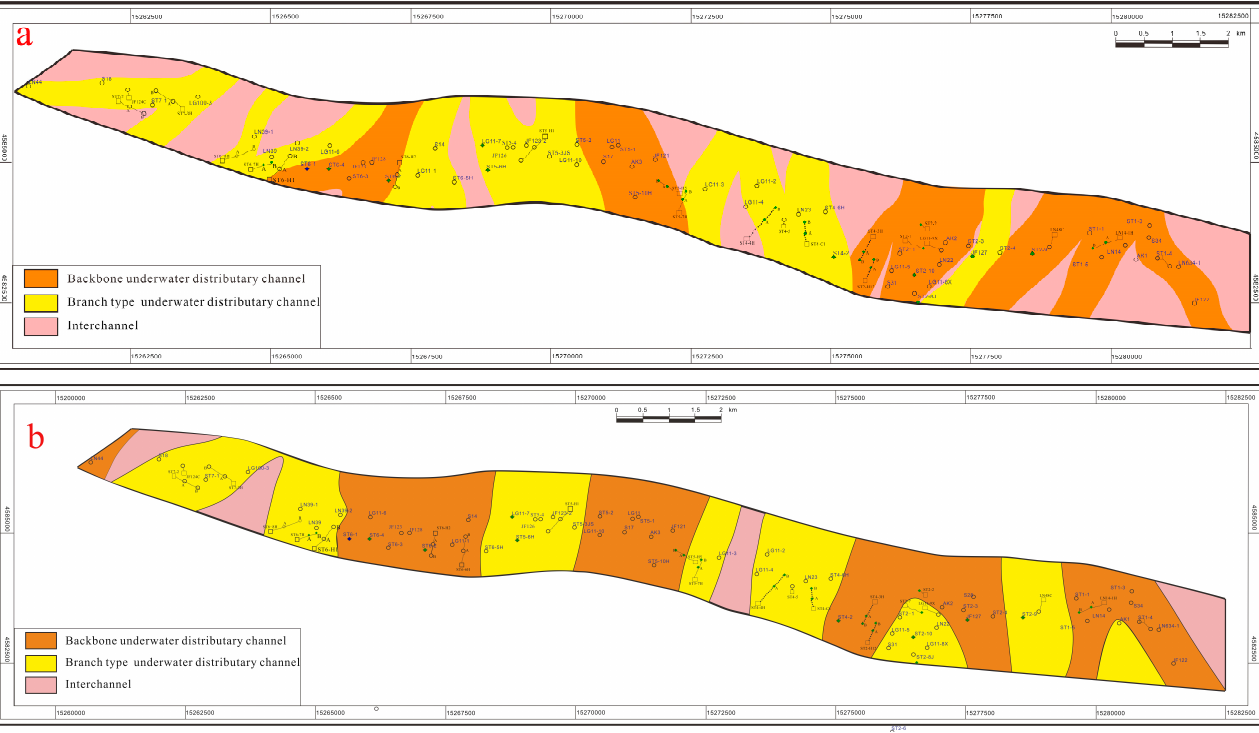
Figure 9. Architecture plan of TIII1 in the Sangtamu Oilfield. (( a ) TIII1-1; ( b ) TIII1-2; ( c ) TIII1-3). 5. Discussion By applying the sedimentary architecture method, we have resolved existing pro- duction contradictions based on the production process of the last 30 years. This method can guide the prediction of the remaining oil distribution in this complex fault block res- ervoir. As an example, consider the Ln22 well block where well X1 started producing oil in February 1993, containing almost no natural gas. It has a nearly 2-year anhydrous oil production period, with a cumulative oil production of 5 × 10 5 tons (as shown in Figure 10a). However, well X2, located 195 m away from well X1, produced a large amount of natural gas resources in 2014 with a gas oil ratio of 2000. The water content of well X2 in- creased rapidly, and the cumulative oil production was only 200 tons (as shown in Fig- ure 10b). The difference in production performance between these two wells was not easily understood before the architecture study. Figure 10. Production curve of wells X1 and X2 in the Sangtamu oilfield. (( a ) Wel X1. ( b ) Well X2). The architecture profiles of X1 and X2 are illustrated in Figure 11. Well X1 has two perforation sections, labeled as ‘a’ and ‘b’. Perforation section a was opened in March